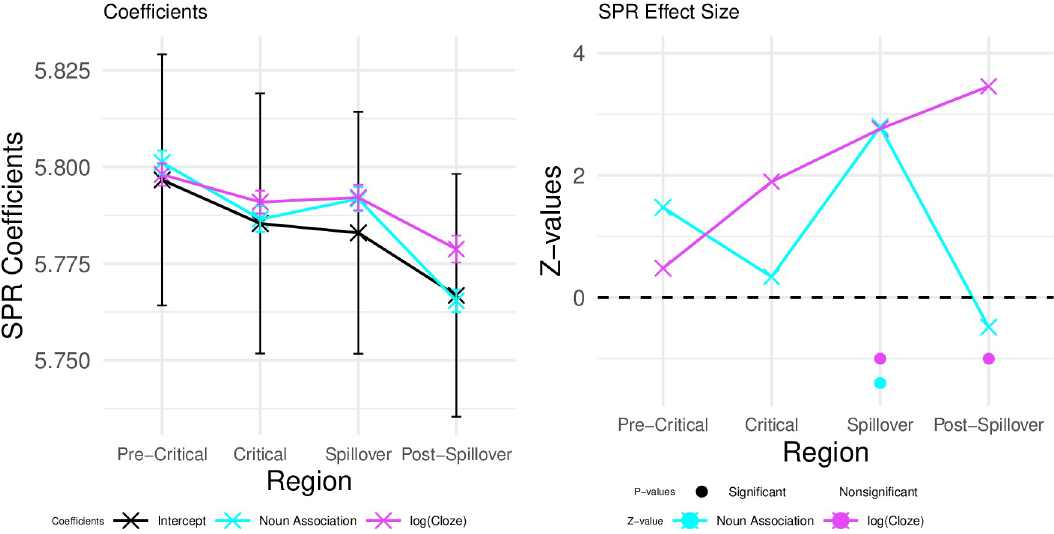
Fig 10. RT coefficients and z-values. Coefficicents (left, added to their intercept), effect sizes (z-values) and p-values (right) for each predictor on the pre-critical, critical, spillover, and post-spillover region. Error bars indicate the standard error on the coefficients from the statistical